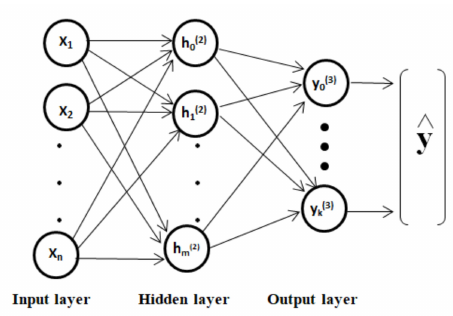
Figure 2. Architecture of the MLP network with a single hidden